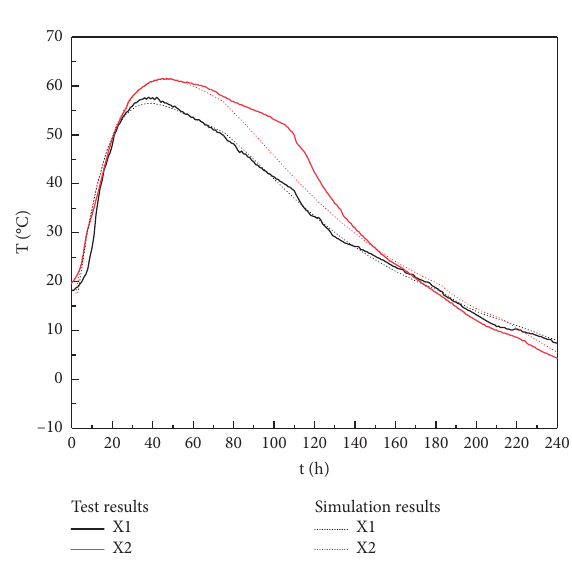
Figure 15: Change in temperature over time at box girder mea- surement points.